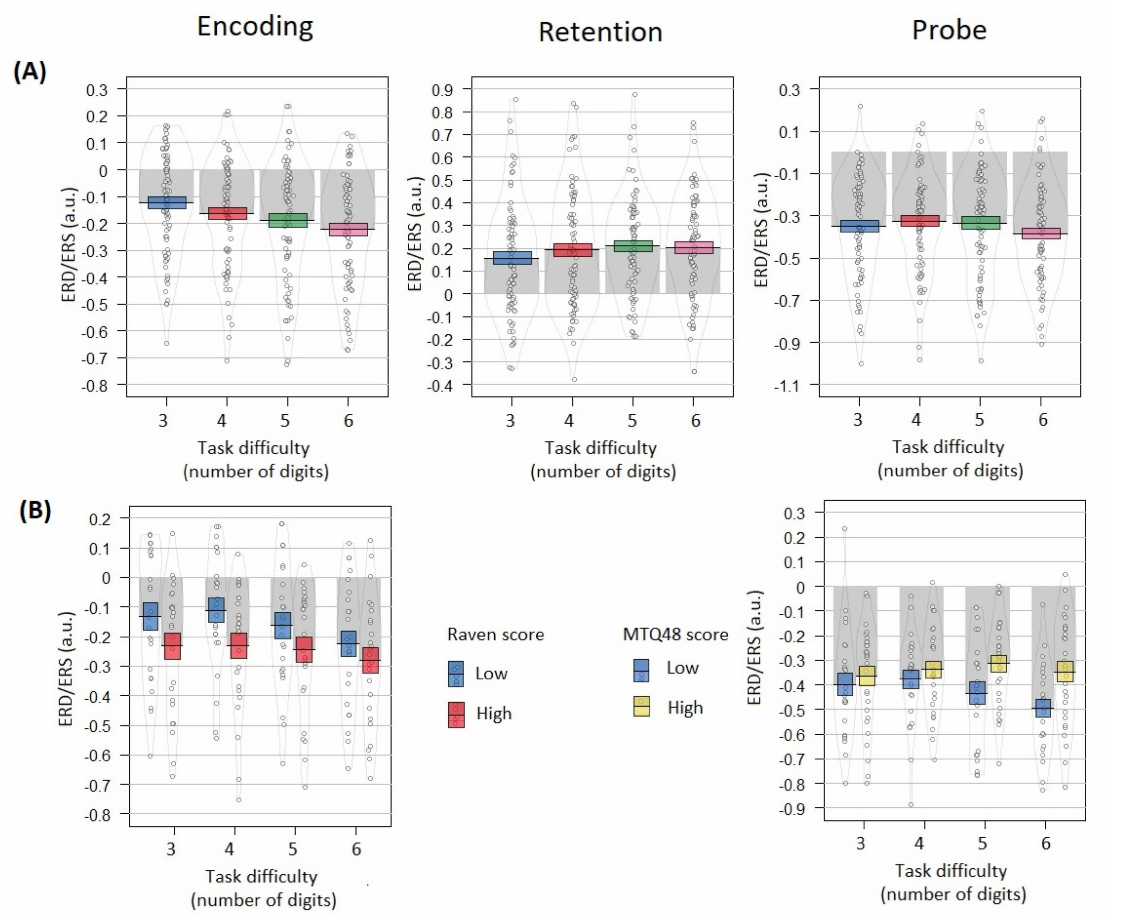
Figure 5. Event-related alpha power by task difficulty and individual differences shown separately for each Sternberg trial phase: left vertical panel—Encoding (300–1000 ms), middle vertical panel— Retention (2300–3300 ms), right vertical panel—Probe (3900–4300 ms). ( A ) Relation of alpha ERD/ERS with task difficulty. Colored bands indicate ± 1 standard errors (blue color corresponds to the 3 digits condition, red—4 digits, green—5 digits, pink—6 digits). ( B ) Interaction between task difficulty and individual differences groups (‘High’—top 30% Raven/MTQ48 score group, ‘Low’—bottom 30% Raven/MTQ48 score group). Only significant results are shown: for the encoding phase, significant interaction between difficulty and Raven score groups was found; for the probe phase, significant interaction between difficulty and MTQ48 score groups was found. Grey bars and black lines indicate means. Dots and density curves indicate data